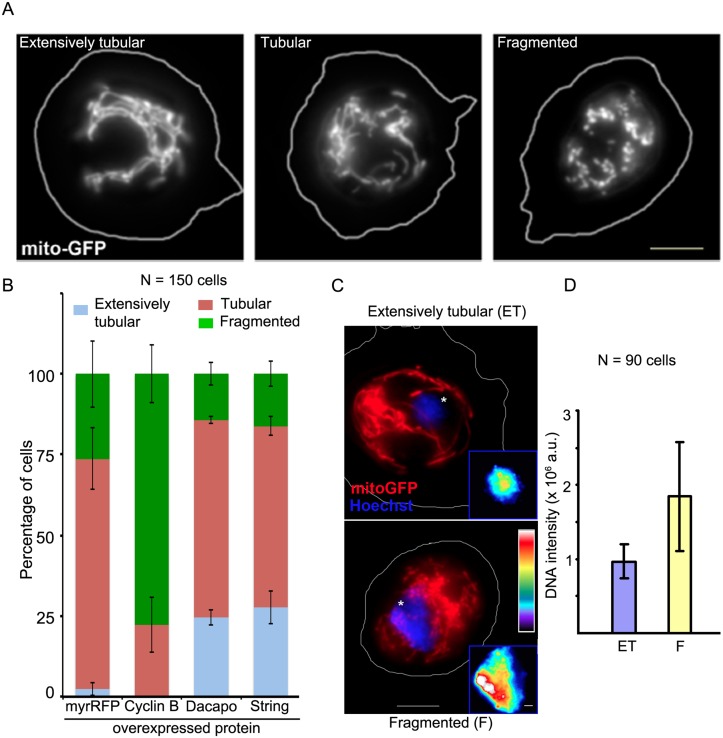

Drosophila larval hemocytes display cell cycle correlated changes in mitochondrial morphology.Mitochondria in hemocytes from third instar Drosophila larvae are visualized using mito-GFP under the control of collagenGAL4. (A) The hemocytes are classified on the basis of mitochondrial morphology as ‘extensively tubular’, ‘tubular’ or ‘fragmented’. (B) Overexpression of cell cycle regulators changes the distribution of mitochondrial morphology. In control hemocytes, expressing mito-GFP and myr-RFP under control of collagenGAL4, 2.3 ± 2.0% cells have extensively tubular mitochondrial morphology, 71.5 ± 9.6% are classified as displaying tubular mitochondrial morphology and 26.2 ± 10.3% as fragmented. Overexpression of cyclin B eliminates the extensively tubular population; cells displaying tubular mitochondrial morphology are reduced to 22.3 ± 8.5% while cells displaying fragmented mitochondrial morphology increase to 77.6 ± 8.9%. The overexpression of Dacapo shows the following distributions 24.5 ± 2.3%—extensively tubular, 61.1 ± 1% tubular and 14.3 ± 3.6% fragmented. The overexpression of String shows the following distributions 27.7 ± 5.2%—extensively tubular, 56.2 ± 3% tubular and 16.1 ± 3.8% fragmented. The overexpression of Dacapo and String increases the extensively tubular population. The histogram shows distribution of mitochondrial morphology (mean ± SEM) from three independent experiments with at least 50 cells per experiment. Differences are significant by t-test (control versus cyclin B, p<0.05, control versus Dacapo, p<0.01, control versus String, p<0.05). (C) Hemocytes derived from cyclin B overexpressing larvae have fragmented mitochondria (recorded by MitoTracker DeepRed) and twice the DNA content (measured by fluorescence of Hoechst 33342), lower image, compared to hemocytes from Dacapo overexpressing larvae that display extensively tubular mitochondria, upper image. The differences in nuclear fluorescence can be compared from equally scaled, pseudo-olored images (insets), where warmer colors indicate greater DNA fluorescence. (D) Hoechst 33342 fluorescence (quantified using ImageJ) doubles from 0.96 x 106 ± 0.22 x 106 arbitrary units (a.u.) in extensively tubular cells to 1.84 x 106 ± 0.73 x 106 a.u. in the fragmented cells. Scale bars A, C, 5 μm, and C inset 1 μm.